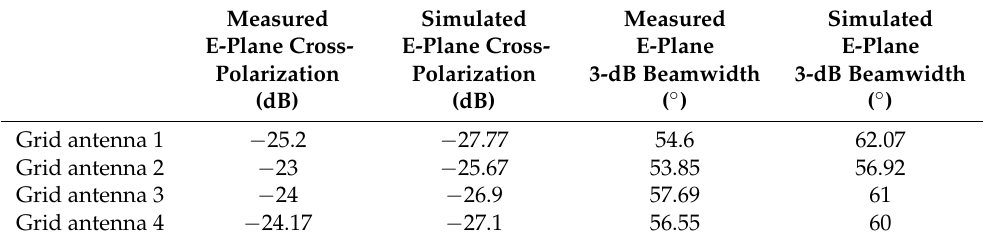
Table 7. Measured and simulated results of E-plane patterns for every antenna element in sparse array.